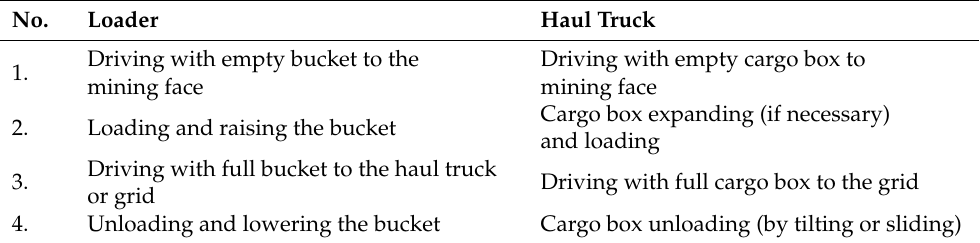
Table 1. Components of a single haulage cycle for loaders and haul